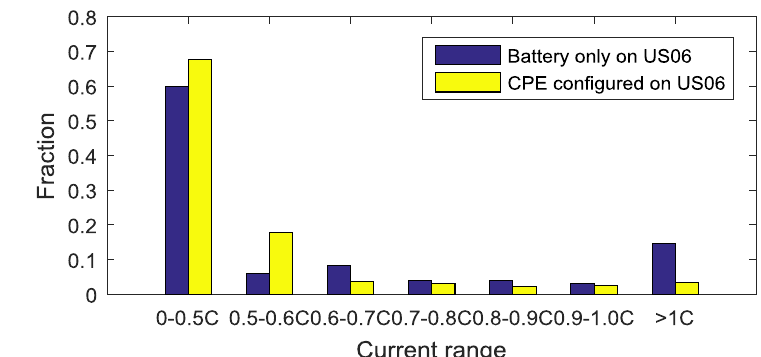
Figure 20. Battery current distribution on US06.